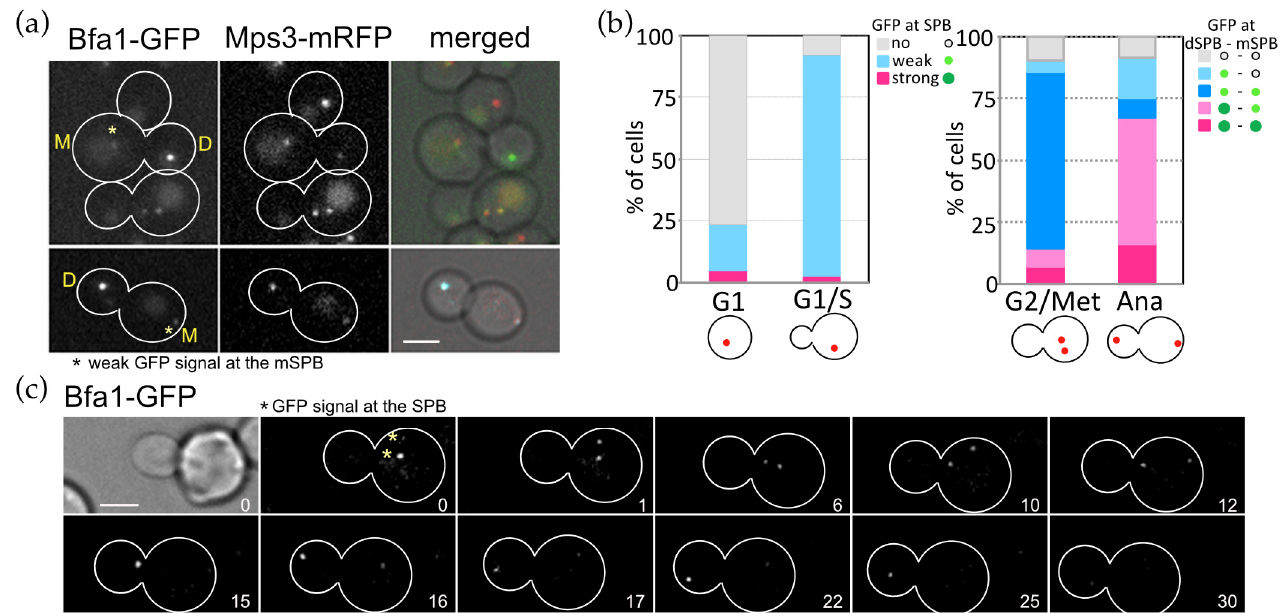
Figure 5. Asymmetric SPB binding of OpBfa1 in the cell cycle. ( a ) Cell cycle dependent localisation of OpBfa1-GFP. OpBFA1-GFP MPS3-mRFP cells (HPH1761) were grown in YPDS medium at 30 °C. Mps3-mRFP is a marker for the SPB. Shown are deconvolved and projected GFP and RFP images and merged brightfield, GFP, and RFP images. Scale bar, 2 µm. Yellow M and D mark the mother and daughter cell compartments of a large budded cell, respectively. Asterisks indicate a weak GFP signal at the mSPB. ( b ) Quantification of cells in a. Cells were categorised based on budding and the number and position of the SPB. GFP signals were judged as no, weak, or strong signals. N > 200 cells. In quantification of G2/Metaphase cells, the SPB locating at the position closest to the bud was designated as dSPB and the other SPB as mSPB. ( c ) Time-lapse microscopy of OpBFA1-GFP MPS3-mRFP cells (HPH1761). Images were taken every 1 min. Only GFP signal was captured. Yellow asterisks indicate metaphase SPBs at the start of the time series. The cell entered into anaphase between the 10 min and 11 min timepoints. Scale bar, 2 µm.